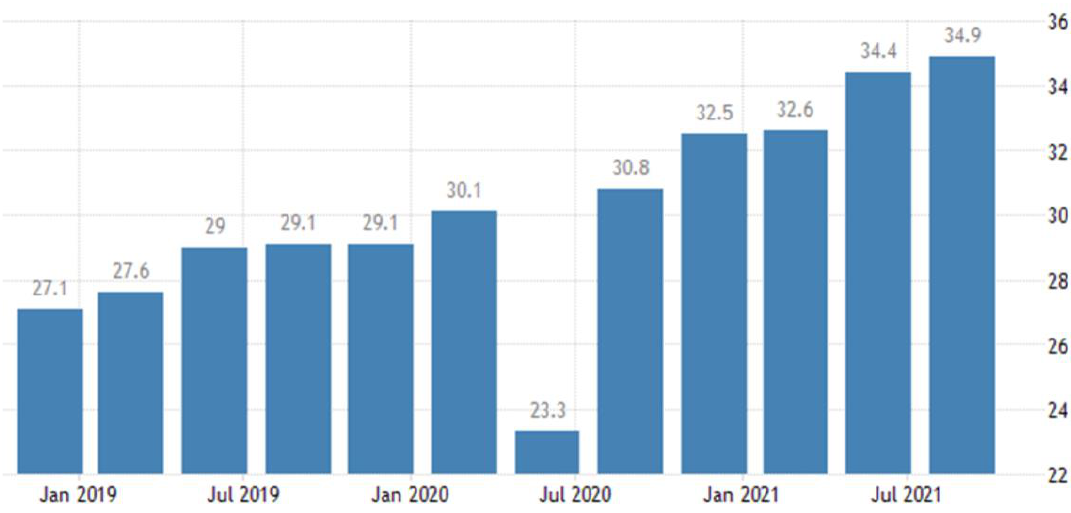
Figure 1. Patterns of Unemployment in South Africa, 2019-2021 Source: Statistics South Africa,